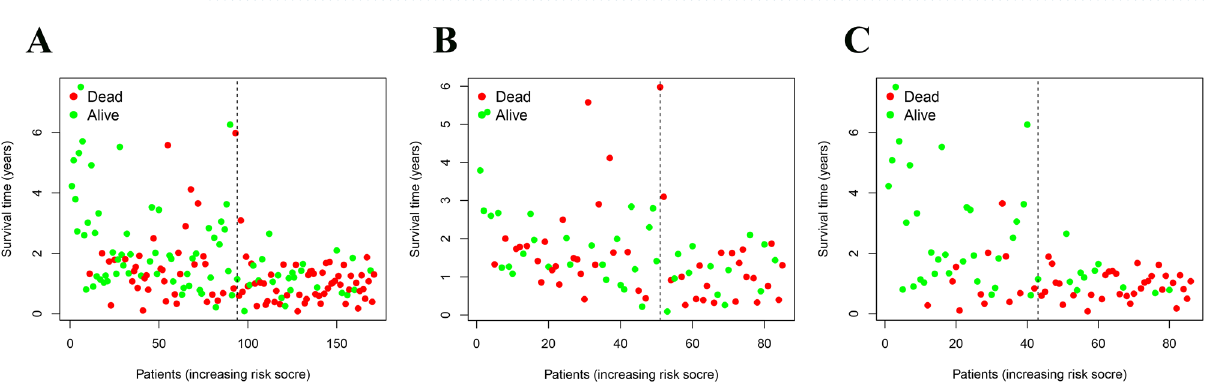
Figure 6. Survival status based on time for the 7-immune-related prognostic miRNA signature in PC. ( A ) survival status analysis in the whole set; ( B ) testing set; ( C ) the training